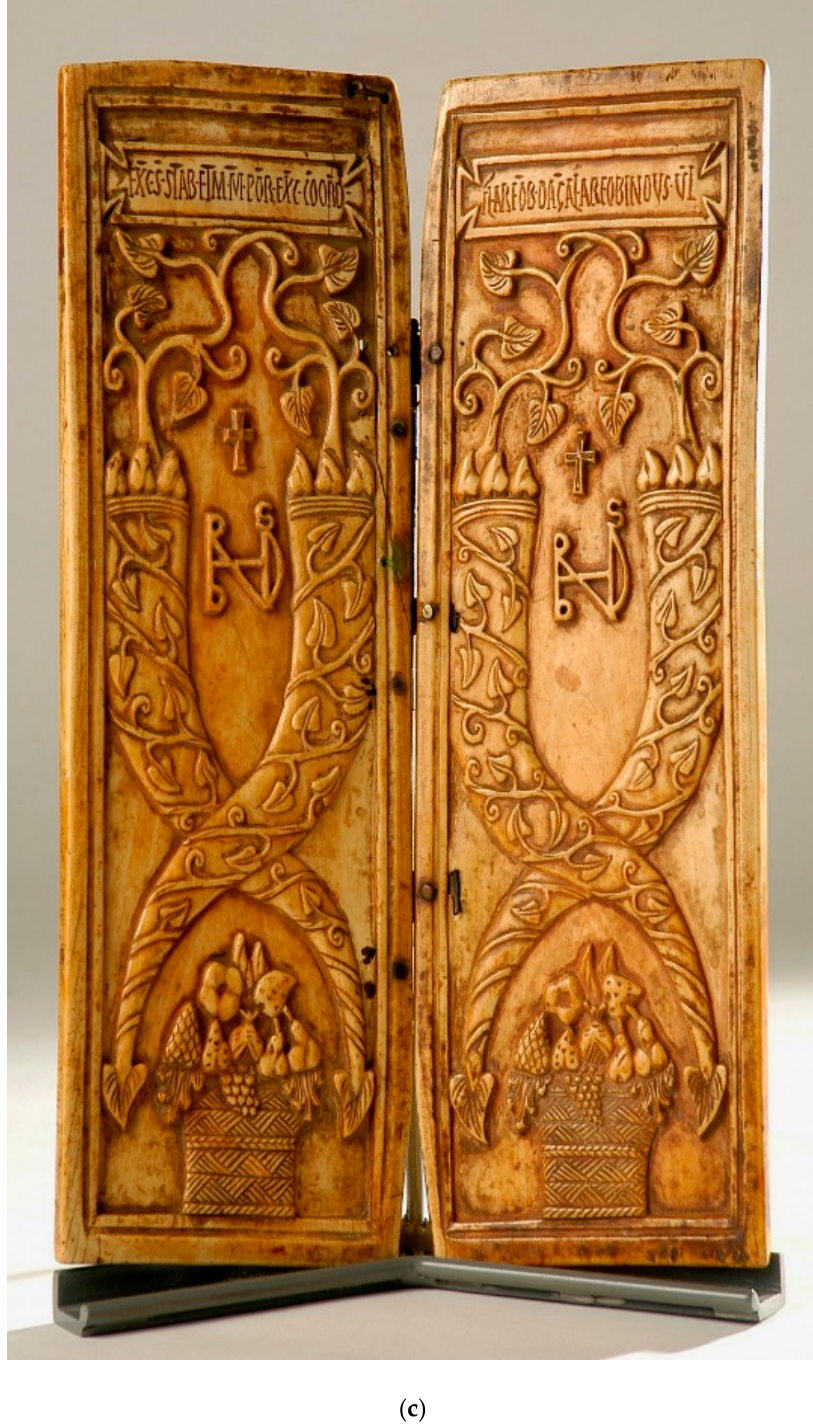
Figure 5. Diverse typologies of Areobindus’ diptychs: ( a ) placque at the Musée de Cluny, Paris, inv. no. CL13135 (photo: © Françoise Foliot, Wikimedia Commons, CC BY-SA 4.0); ( b ) diptych at the Mus é e du Louvre, inv. no. OA9525 (photo: © Marie-Lan Nguyen, Wikimedia Commons, CC BY 2.5); ( c ) diptych at the Museo della Cattedrale, Lucca (photo: courtesy of Opera del Duomo di Lucca).